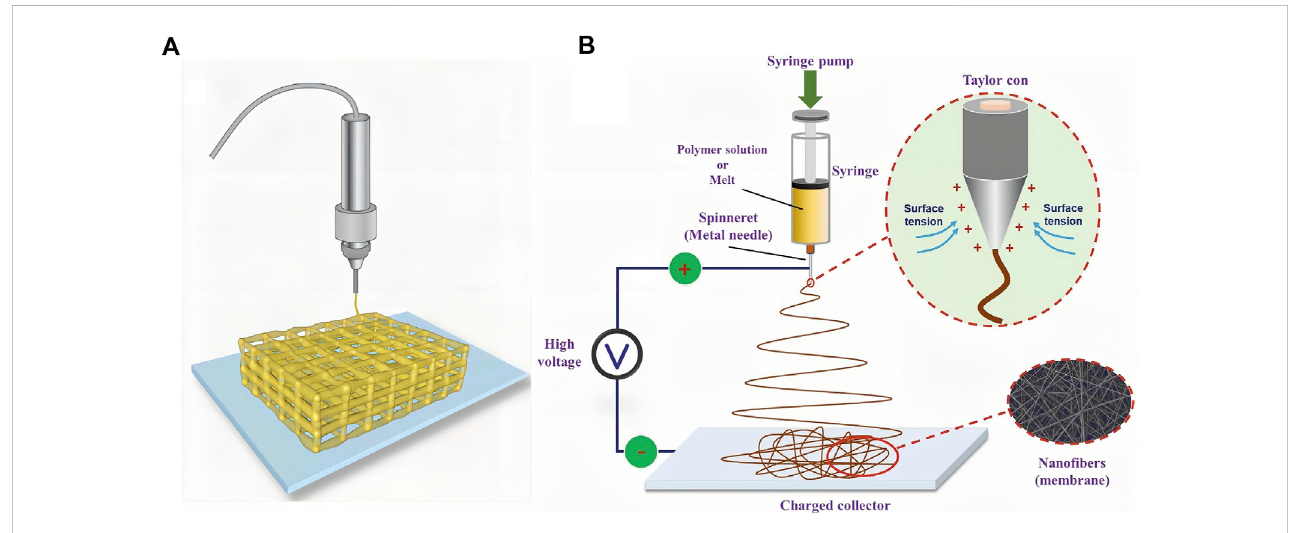
FIGURE 6 Two kinds of new representative hydrogel fabricating methods. (A) Schematic diagram of 3D-printed hydrogel scaffold. Taken from (An et al., 2020). (B) Schematic of a conventional electrospinning process with a single jet. [Reprinted with permission from Ref. (Li et al., 2020). Copyright 2020